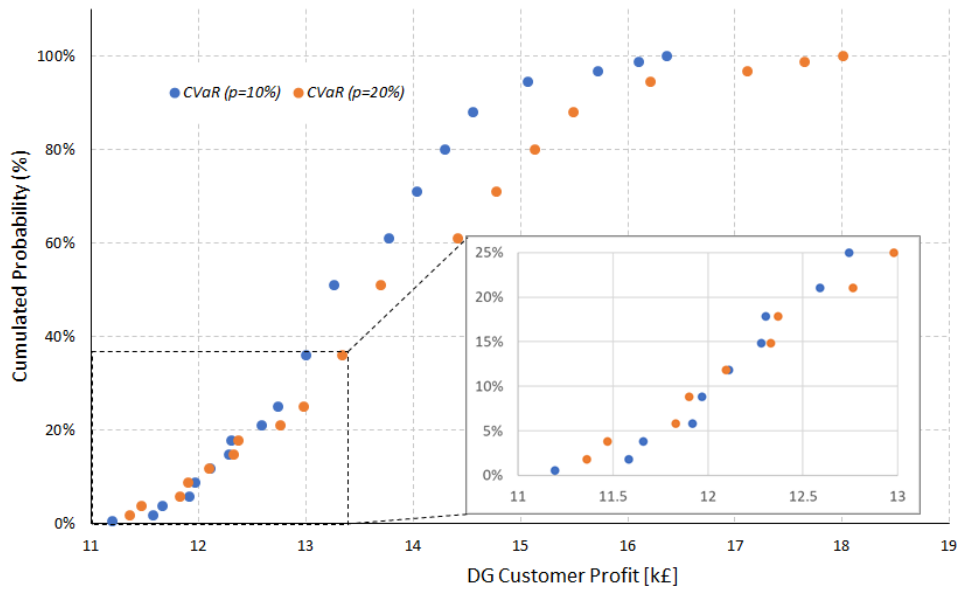
Figure 3. Consumer benefit using CVaR as hedge instrument.